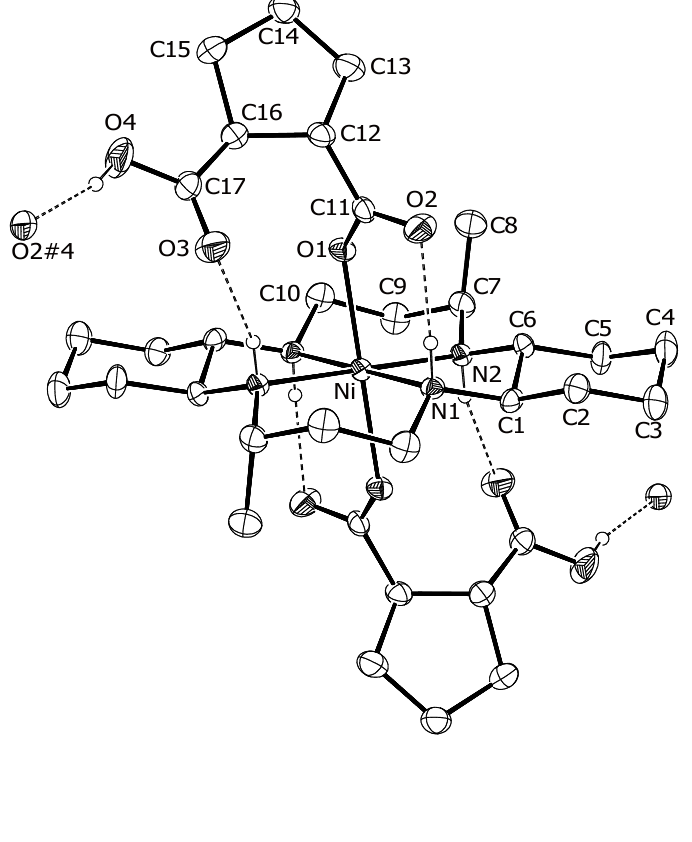
] ( 1 ) with the atomic numbering 2